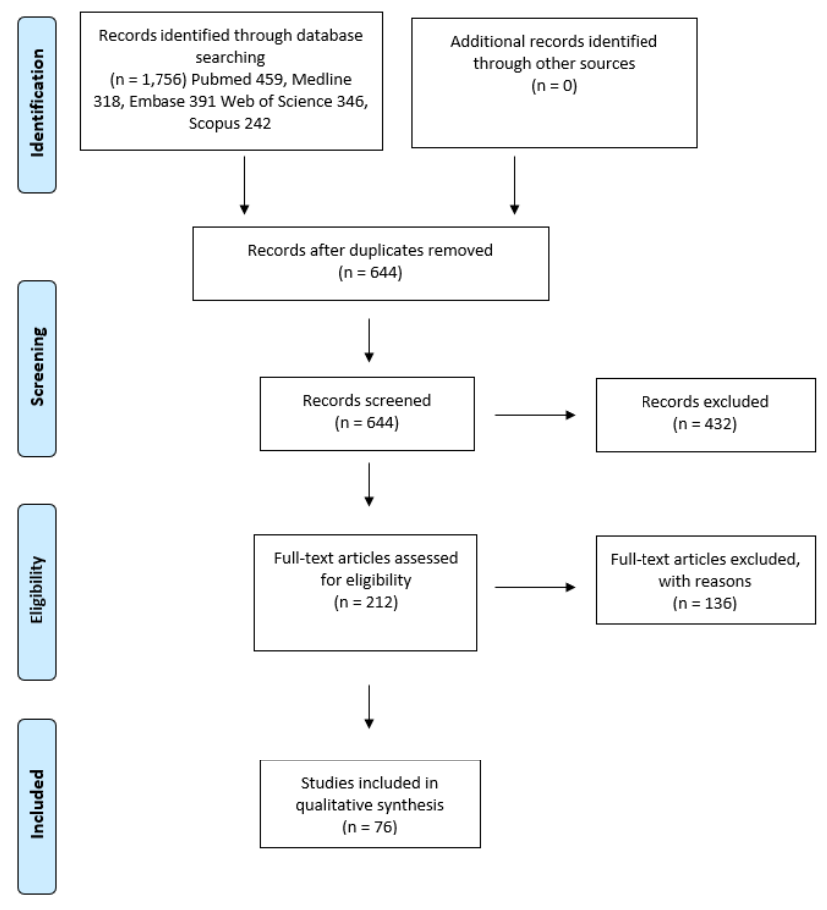
Figure 1. Article selection flow chart for the systematic review using Preferred Reporting Items for Systematic Review and Meta-analysis (PRISMA) guidelines.